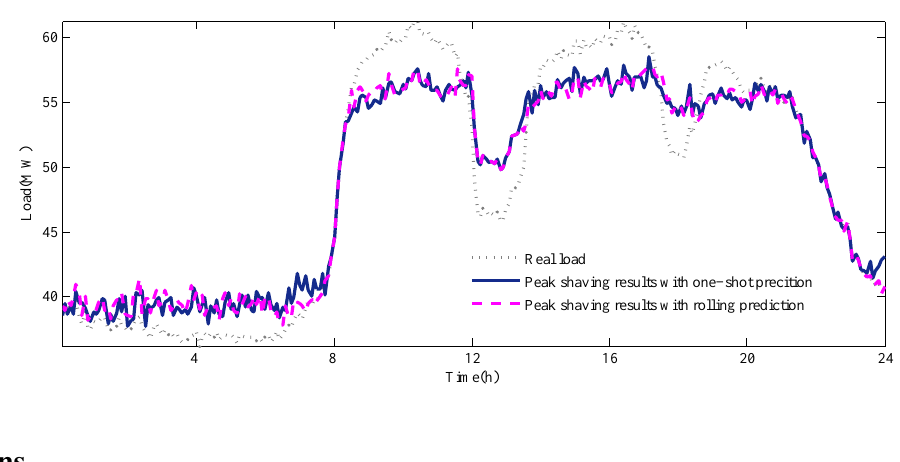
Figure 8. Peak load shaving results under one-shot optimization and